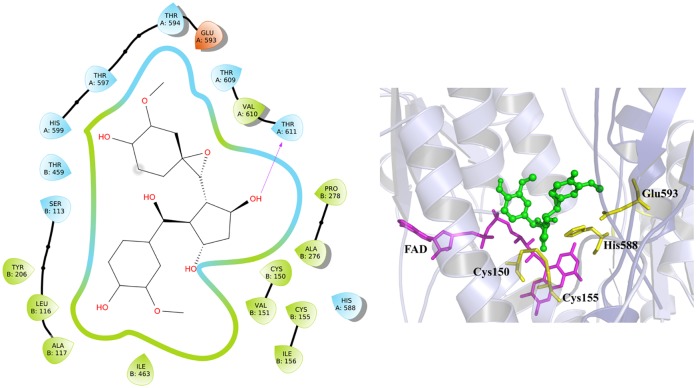
Binding site and interactions of spiroepoxide on TGR.Scheme (a) shows a two-dimensional view of the amino acid residues of the enzyme involved in the interaction with spiroepoxide. In (b) a three-dimensional view of the binding site showing FAD (purple sticks), spiroepoxide (green sticks), as well as the catalytically essential Cys150, Cys155, His588, and Glu593 (yellow sticks) is shown.